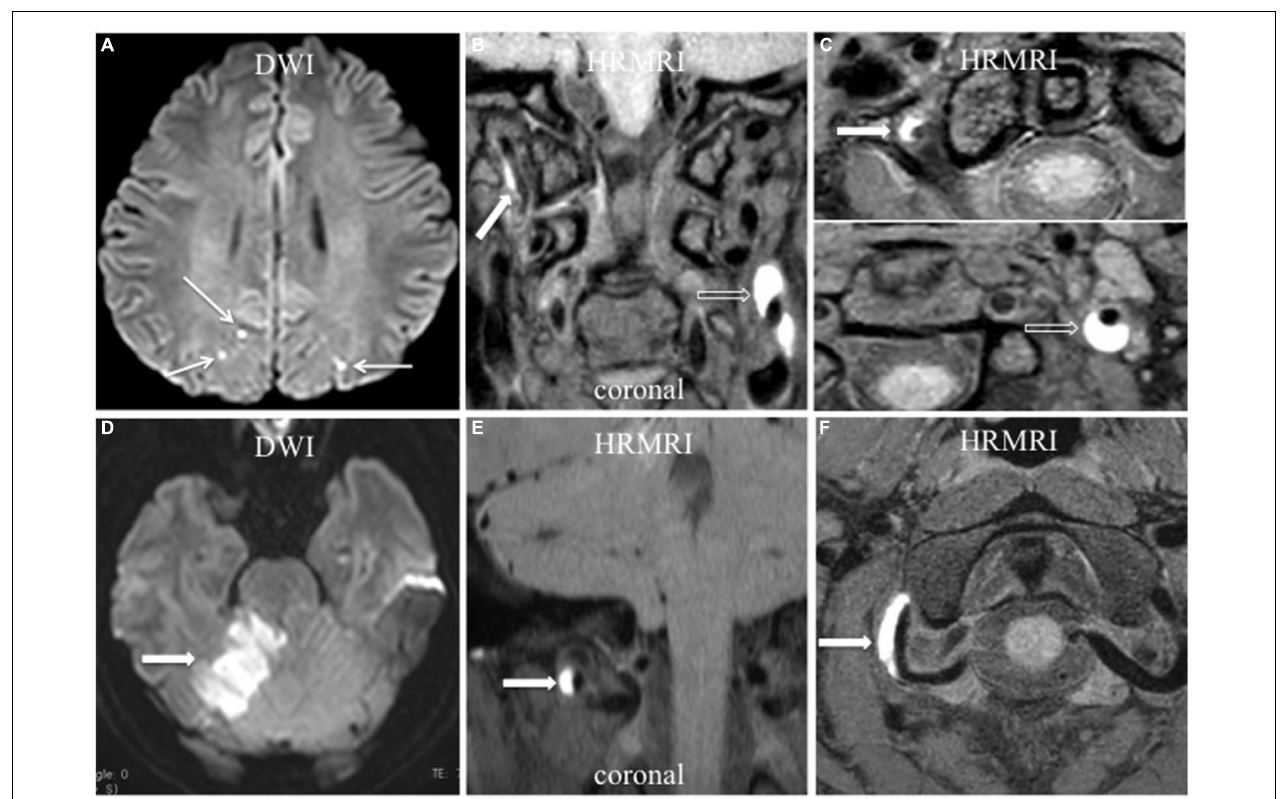
FIGURE 4 | Acute ischemic stroke associated with vertebral artery dissection. (A–C) Multiple acute ischemic stroke lesions in the parietooccipital junction bilaterally ( A , arrow) with dissection in the right vertebral artery and left ICA. T1-weighted HRMRI showed an intramural hematoma in the right vertebral artery ( B,C , arrow) and left ICA ( B,C , empty arrow) in the coronal and transverse planes. (D–F) Acute ischemic stroke in the right cerebellum ( D , arrow) with V3 segment dissection of the right vertebral artery. T1-weighted HRMRI showed an intramural hematoma in the right vertebral artery in the coronal ( E , arrow), and transverse ( F , arrow) planes.